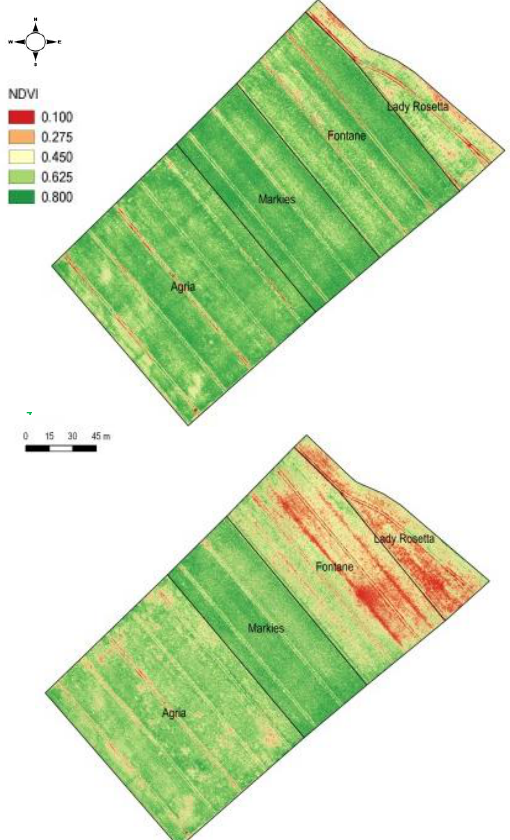
Figure 14. NDVI of potato fields with developing potato blight (red spots) monitored on the 17 th of July (top) und 31 st of July 2014 (bottom) (Canon S110 NIR, GSD 5 cm).